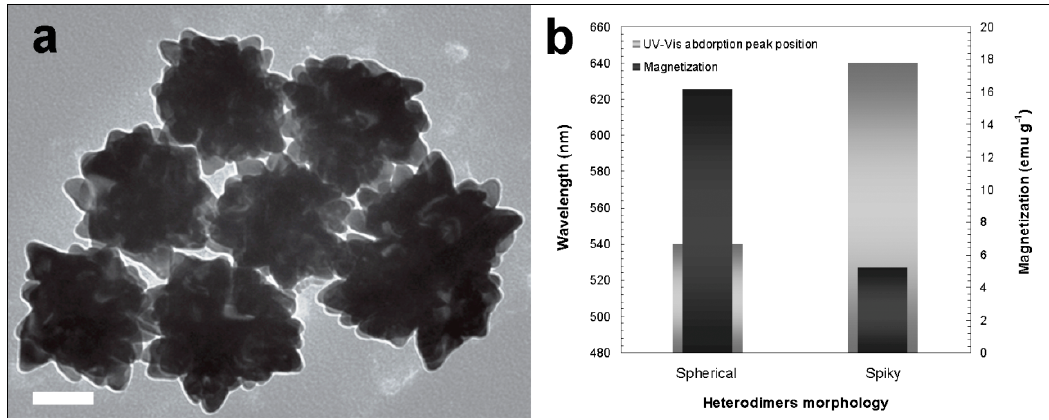
Figure 6. Fe 3 O 4 -Au heterodimers. TEM image of spiky-shaped structure, scale bar: 100 nm ( a ) and Variation charts of magnetization and UV-Vis absorption peak position as a function of morphology ( b ). Adapted from reference [177].